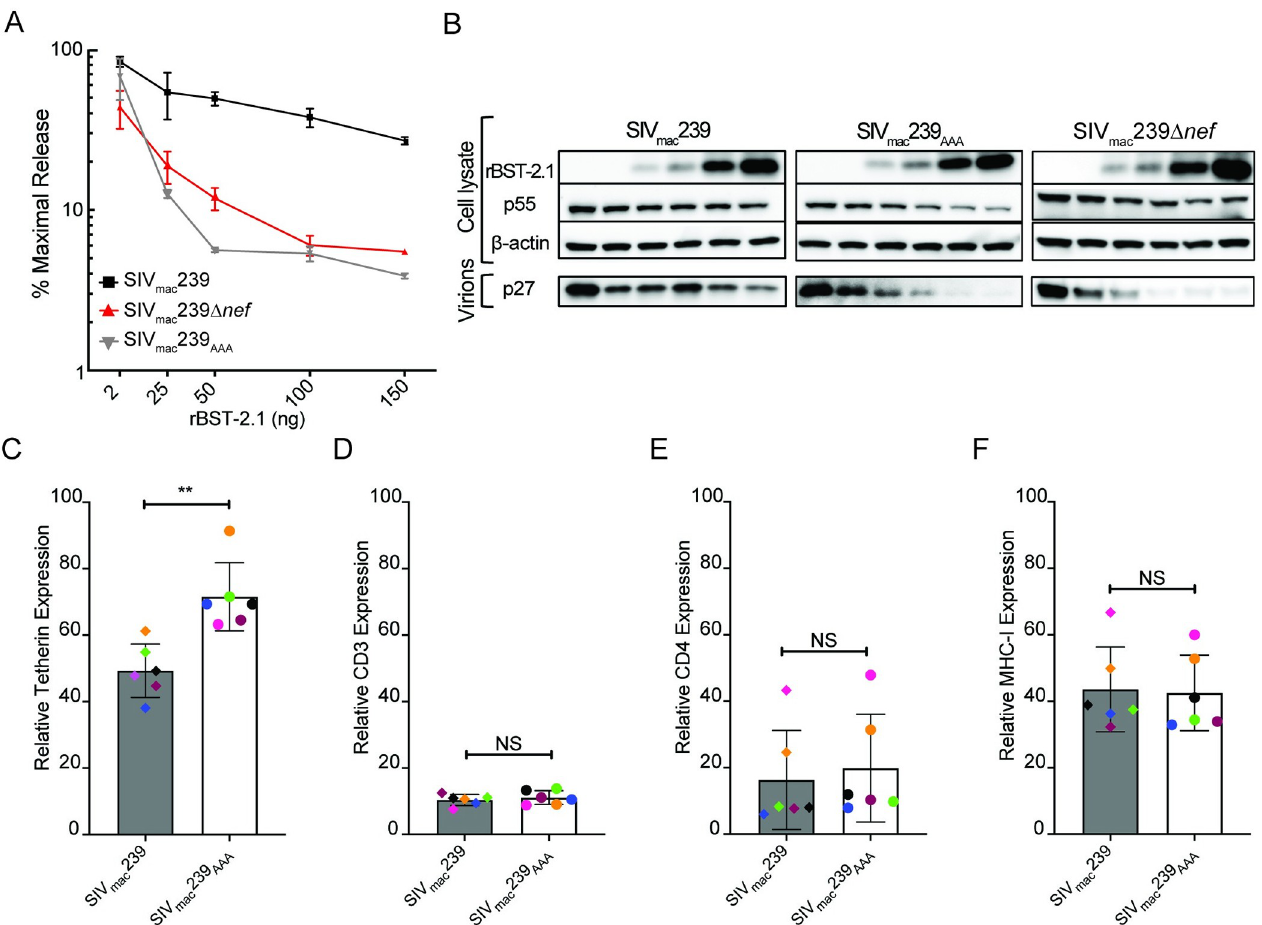
Fig 2. Phenotypic characterization an infectious molecular clone of SIV with substitutions in Nef that selectively impair tetherin antagonism. SIV mac 239 AAA , SIV mac 239 and SIV mac 239 Δ nef were tested for resistance to tetherin (A & B), and for downmodulation of tetherin (C), CD3 (D), CD4 (E) and MHC I (F) from the surface of infected primary CD4 + lymphocytes. (A) 293T cells were co-transfected with full-length clones for SIV mac 239, SIV mac 239 Δ nef or SIV mac 239 AAA and increasing amounts of an expression construct for rhesus tetherin (rBST-2.1). The accumulation of SIV p27 in supernatant was measured by antigen-capture ELISA and percent maximal release was calculated relative to control transfections in the absence of tetherin. (B) Differences in virus release were corroborated by western blot analysis of virions and cell lysates. Proteins were separated by SDS-PAGE, transferred to PVDF membranes and stained with antibodies to tetherin (rBST-2.1), β -actin, and the SIV Gag p27 and p55 proteins. (C-F) Activated CD4 + lymphocytes from six different macaques were infected with SIV mac 239 AAA , SIV mac 239 and SIV mac 239 Δ nef . On day 6 post-infection, the cells were stained for surface expression of tetherin, CD3, CD4 and MHC I, and for intracellular expression of the SIV Gag protein. Relative expression levels of tetherin (C), CD3 (D), CD4 (E) and MHC I (F) were determined by comparing the gMFI of each of these molecules on virus-infected (CD4 lo Gag + ) cells to uninfected cells (CD4 hi Gag - ). Error bars indicate standard deviation of the mean and significant differences are indicated by asterisks ( �� p < 0.01 & NS, not significant, two-tailed unpaired t-test with Welch’s correction in case of unequal